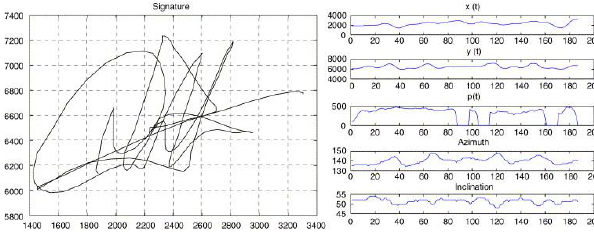
Fig. 5: Example of signature with static and dynamic features (taken from